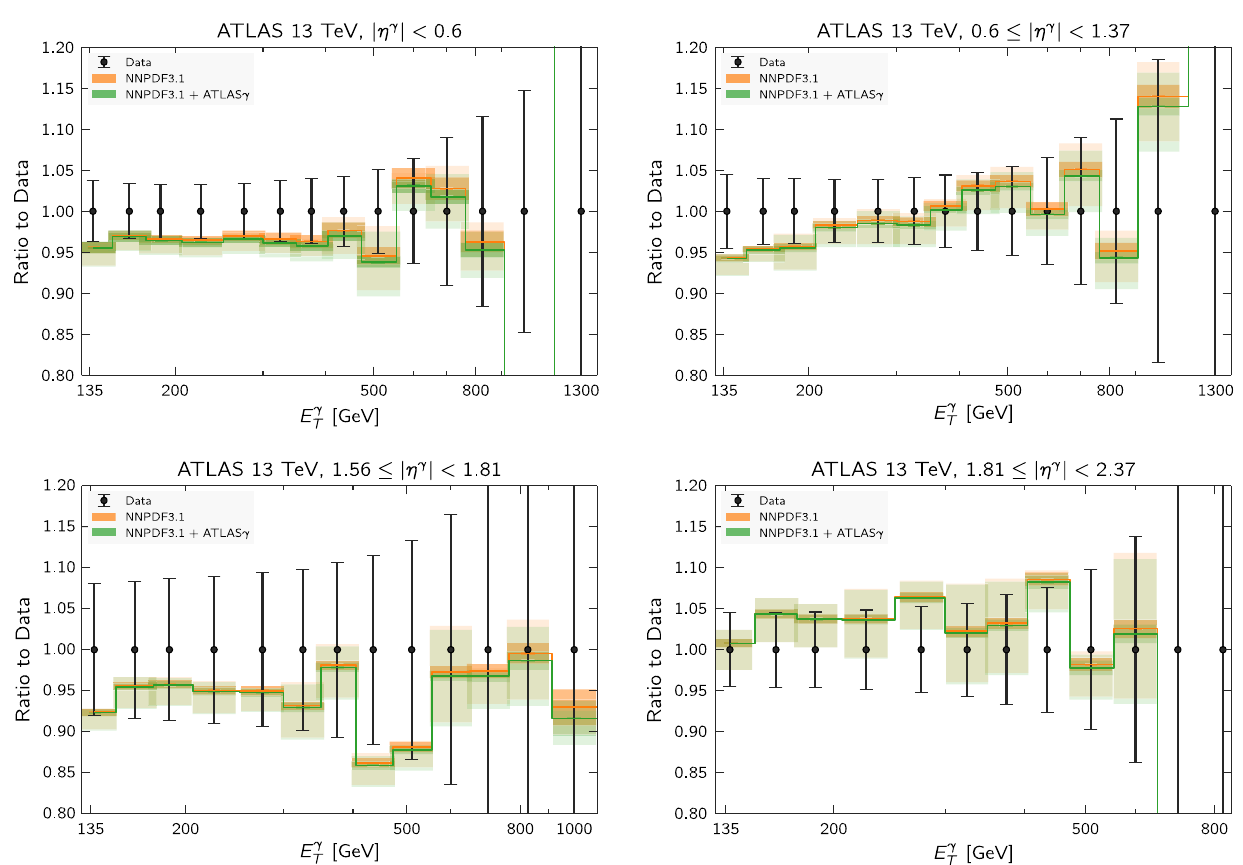
Fig. 10 Same as Fig. 8 for the ATLAS 13 TeV direct photon measurements. In addition to the PDF uncertainties shown in the previous cases (darker bands), here we also include the scale uncertainties associated to the NNLO QCD calculation (lighter